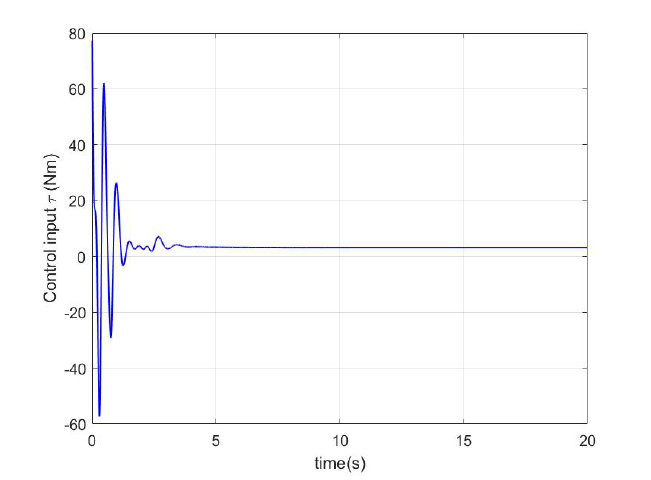
Figure 3. The control input of (17) in Case 1.